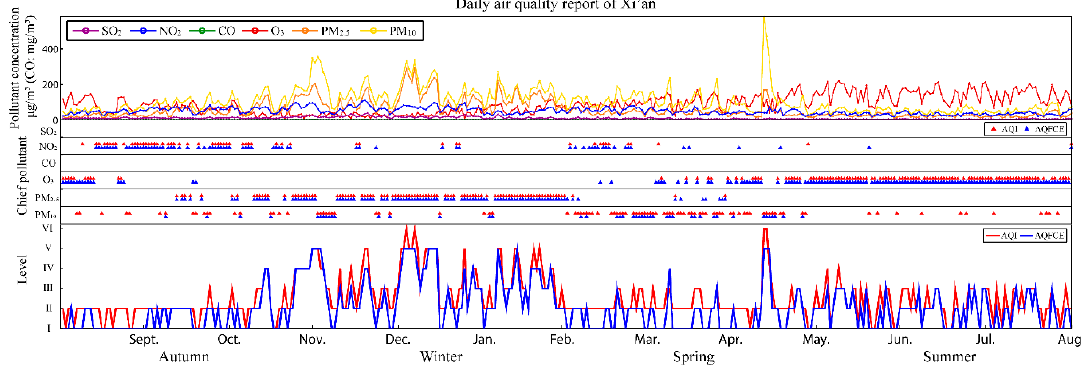
Figure 7. Daily pollutant concentration variation and air quality evaluation result of chief pollutant and level of Xi’an. Appl. Sci. 2020 , 10 , x FOR PEER REVIEW